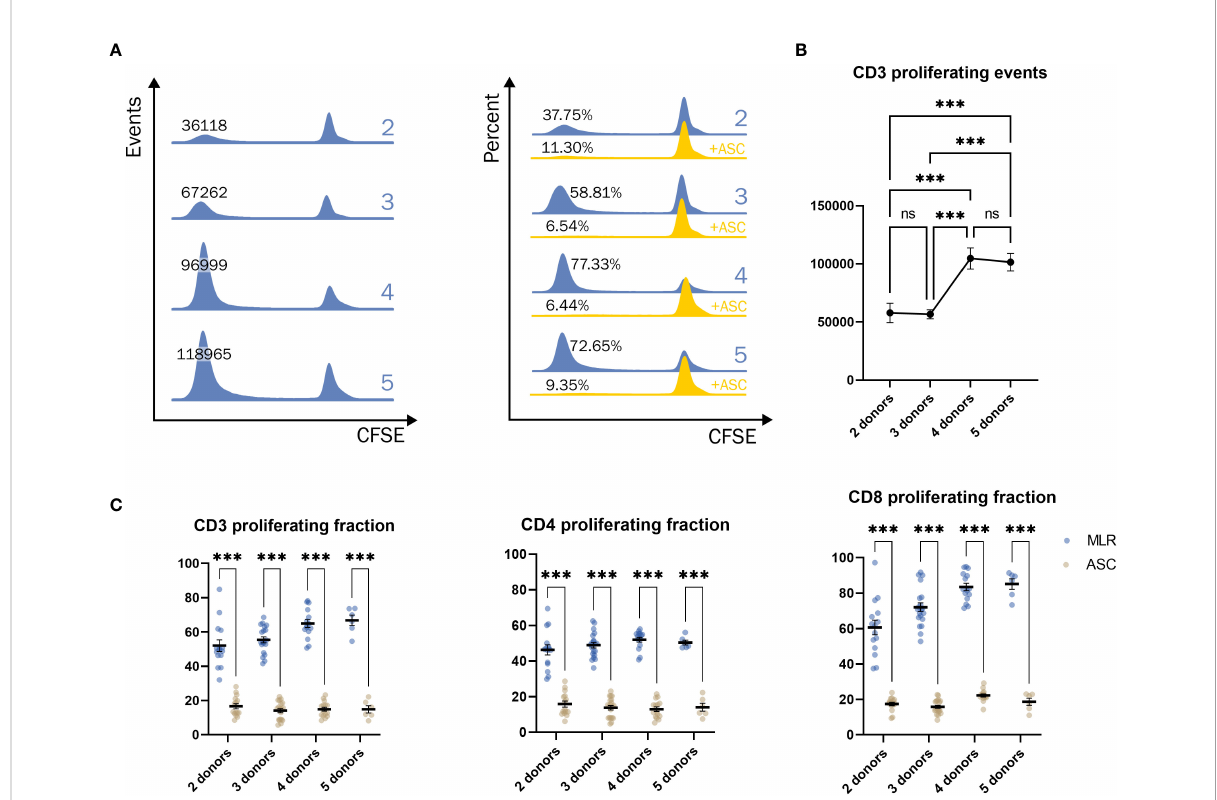
FIGURE 4 Signi fi cant increase in response when combining 4 donors or more. (A) Example of the proliferative response of T cells when combining a pool of 2, 3, 4, or 5 donors in events (blue, left) and percentages (blue, right). Addition of ASC greatly reduced the response (yellow, right). (B) The number of T cells when combining a pool of 2, 3, 4, or 5 PBMC donors. One-way ANOVA. (C) The percentage of proliferating CD3+ (left), CD4+ (middle), and CD8+ (right) cells from different combinations of pooled PBMC donors. Two-way ANOVA. Signi fi cance levels of *) p < 0.05; **) p < 0.01; ***) p < 0.001. The number of combinations is described in methods. PBMC, Peripheral Blood Mononuclear Cells; MLR, mixed lymphocyte reaction; CFSE, Carboxy fl uorescein succinimidyl ester; ASC, Adipose tissue-derived Stromal Cells; ns, not signi fi